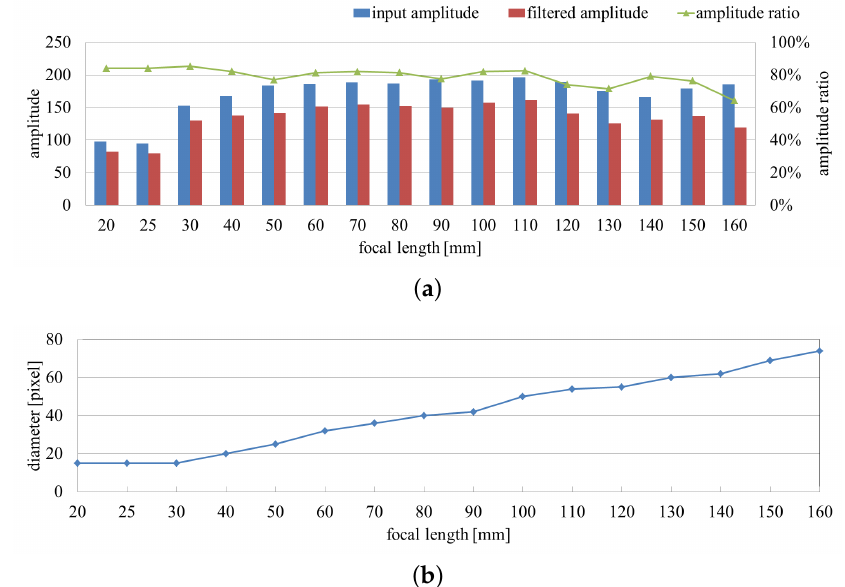
Figure 9. Averaged amplitudes and extracted region sizes with focal length variation. ( a ) Averaged amplitudes of input and pixel-wise filtered images and their ratios on the extracted pixels; ( b ) diameters of extracted vibration